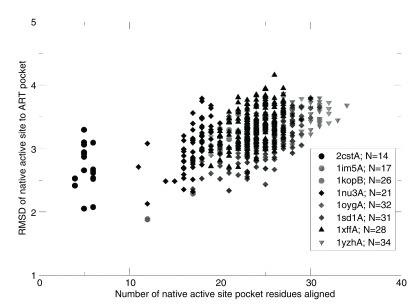
Root-mean-square-deviation (RMSD) of native enzymatic to ART pockets versus the number of pocket residues aligned.The number of residues in the native active site pocket, N, is shown in the figure legend.